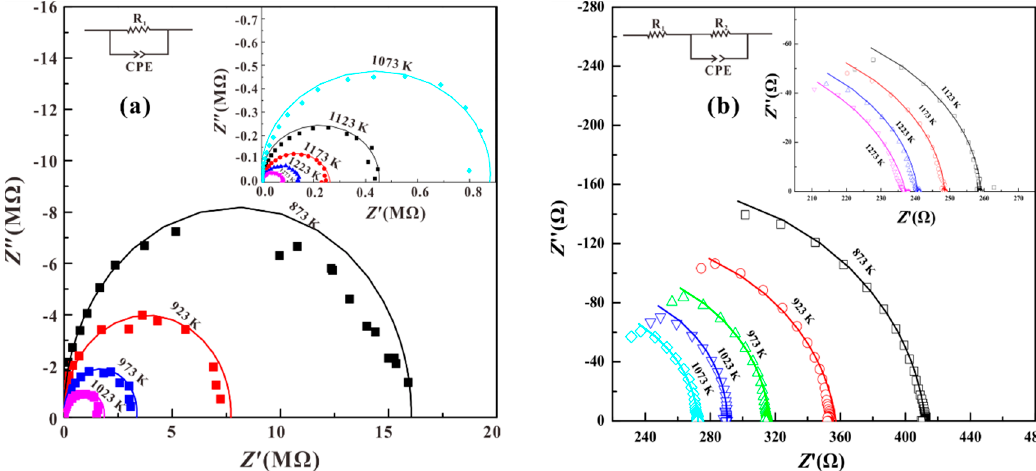
Figure 4. Two sets of typical complex impedance spectra of the magnetite-free ( a ) and 5 vol. % magnetite-bearing ( b ) olivine aggregates at frequencies from 10 –1 to 10 6 Hz (right to left), obtained under conditions of 2.0 GPa and 873–1273 K. Z ' and Z " are the real and imaginary parts of the complex impedance, respectively. The equilibrium circuit was made up of a parallel non-ideal constant phase element (CPE) and the resistance was selected to fit the impedance semicircular arc for magnetite-free aggregates. As for the magnetite-bearing samples, the complex impedance spectra were fitted using an equivalent circuit of a series connection of one resistance and the constant phase element with a resistance in parallel.